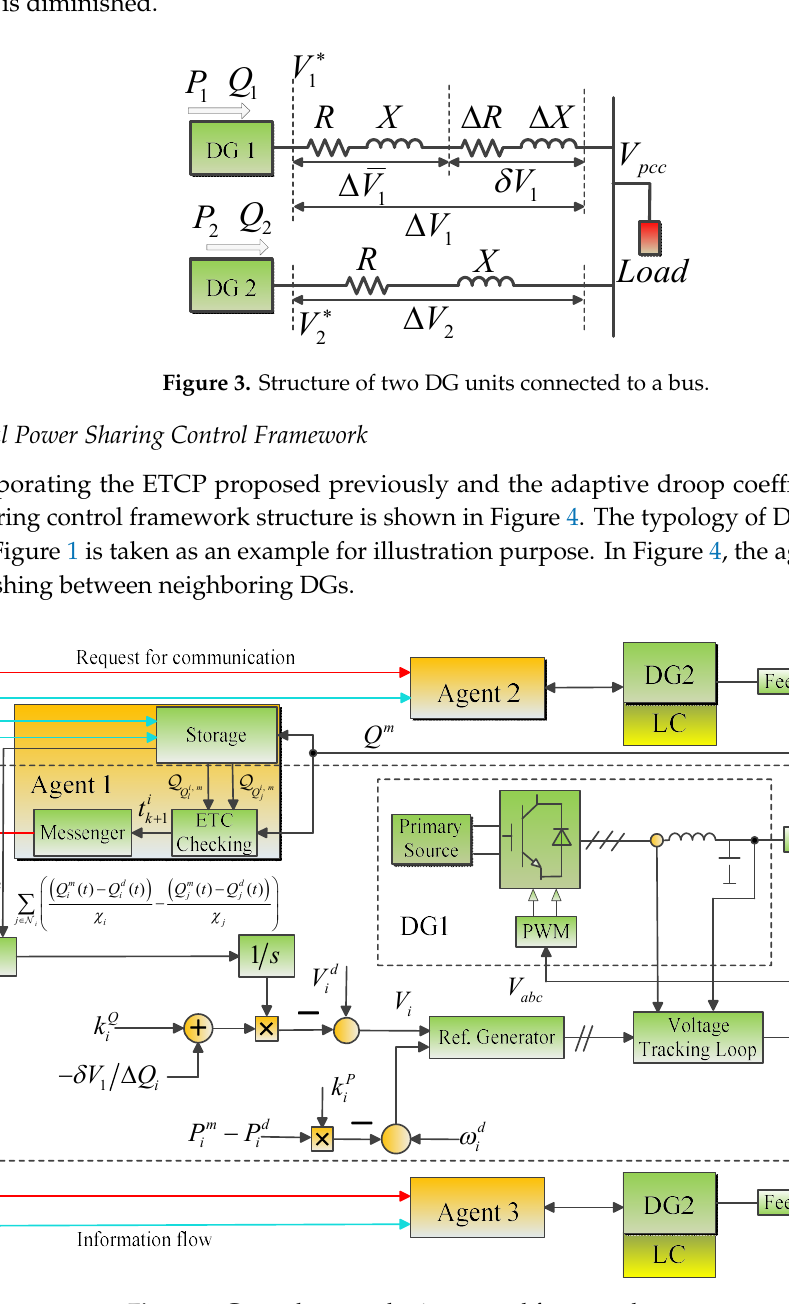
Figure 4. General power sharing control framework structure